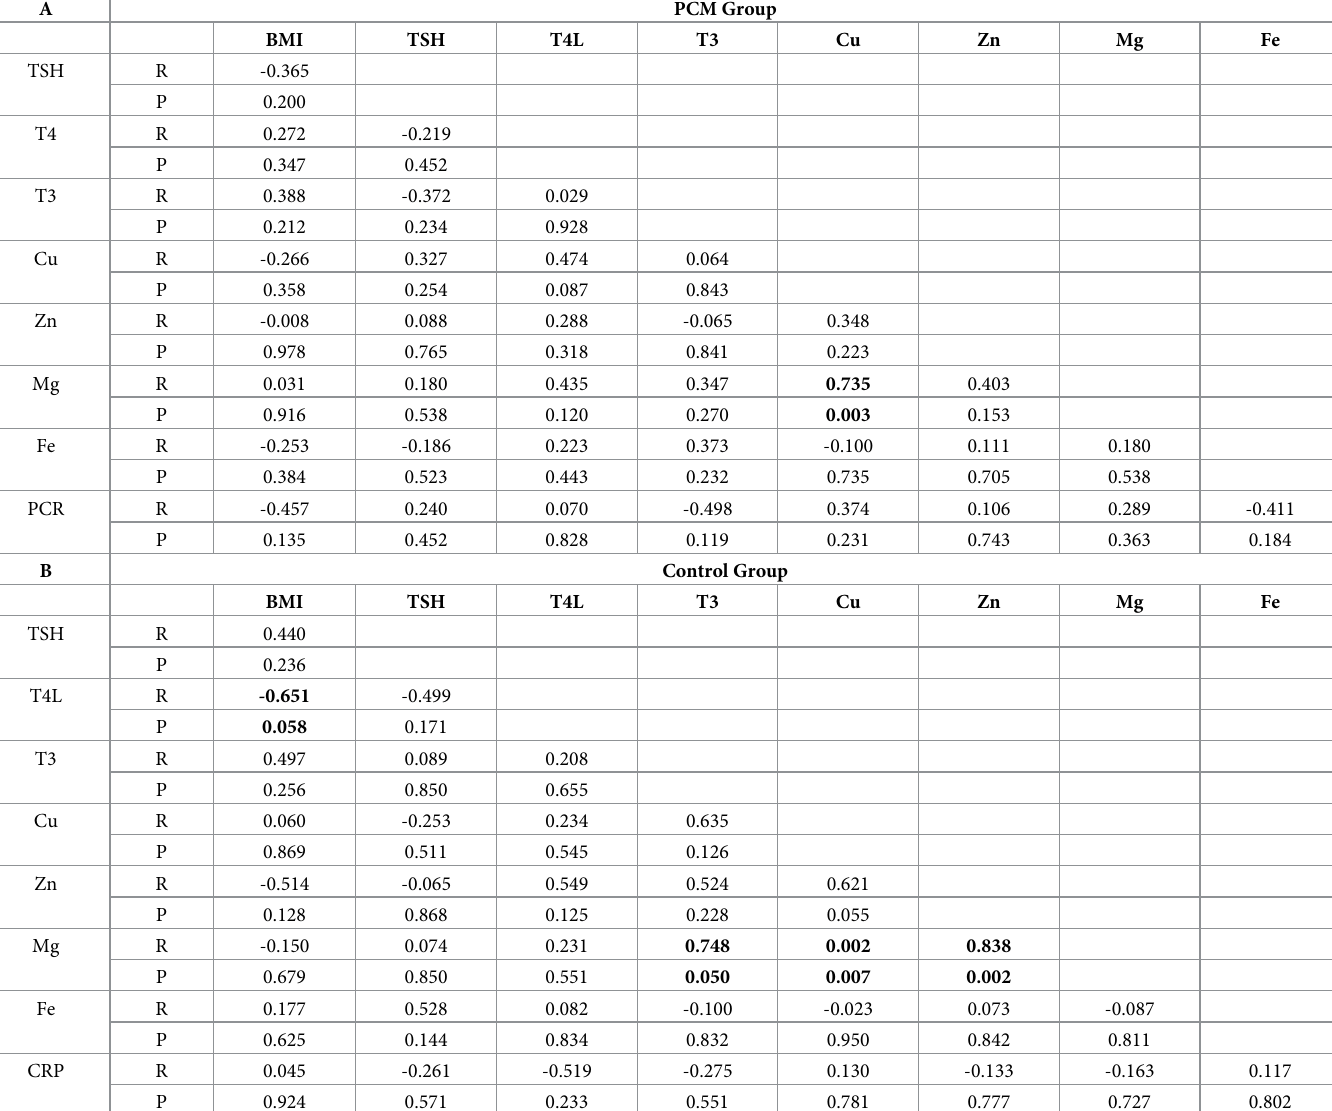
Table 5. Correlation between serum levels of minerals, proteins, and thyroid hormones and body mass index (BMI) in 14 patients with paracoccidioidomycosis (PCM group) before treatment (A) and in 10 healthy subjects (control group) (B).